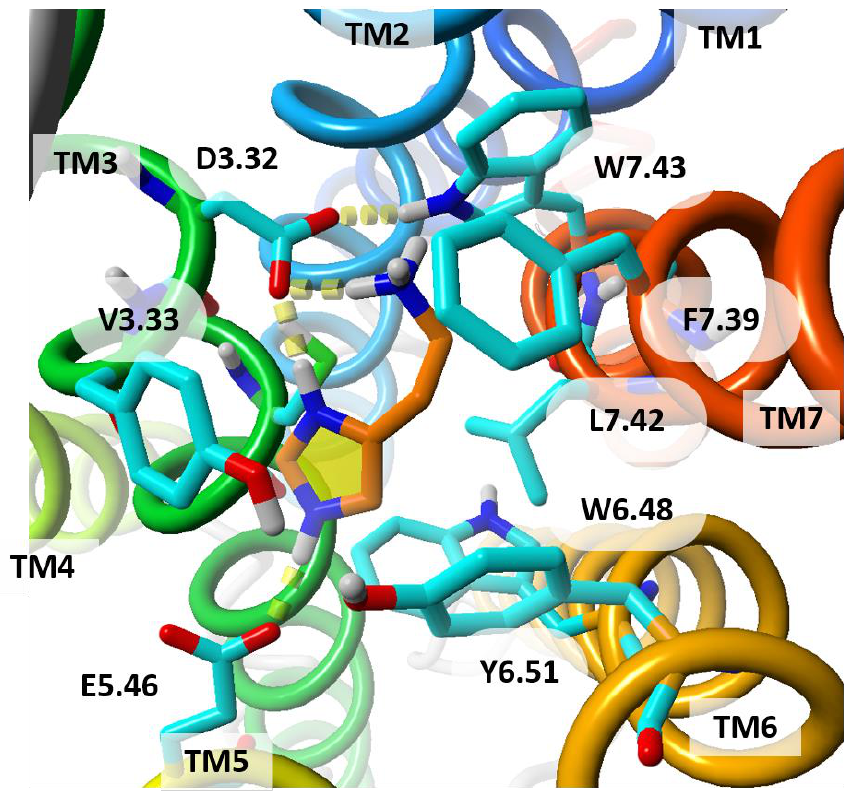
Figure 6. Histamine molecule docked to the homology model of hH 3 R. The histamine is doubly positively charged. Both charged moieties of histamine are bound to D 3.32 . The imidazole ring is additionally bound to E 5.46 . The histamine hydrophobic linker is exposed toward hydrophobic residues F 7.39 and L 7.42 . The residue numbers are shown in Ballesteros-Weinstein numbering scheme. Histamine is shown with its carbon atoms colored in orange. View from extracellular side. TM helices are colored from blue (TM1) to red